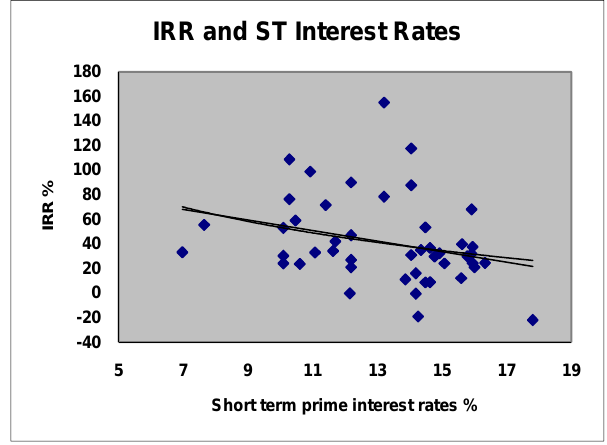
Figure 6: IRR and ST interest rates scatter plot Size of investment